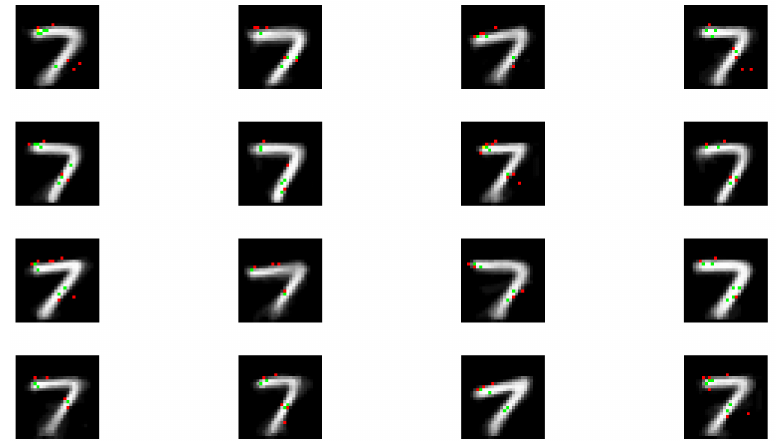
Figure 6. Centroids of 16 rules with their antecedents generated from R 67 in the fully connected